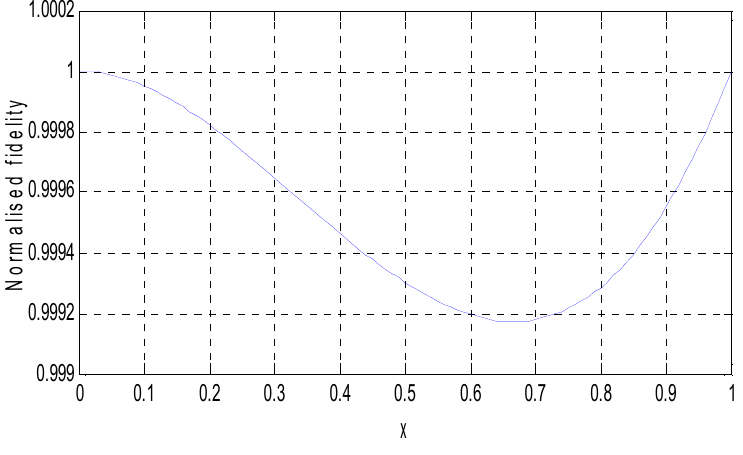
Figure 4. Fidelity of primary voltage conditioning amplifier.